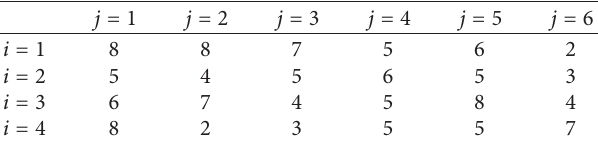
Table 5: Required time to carry out tasks by employees.